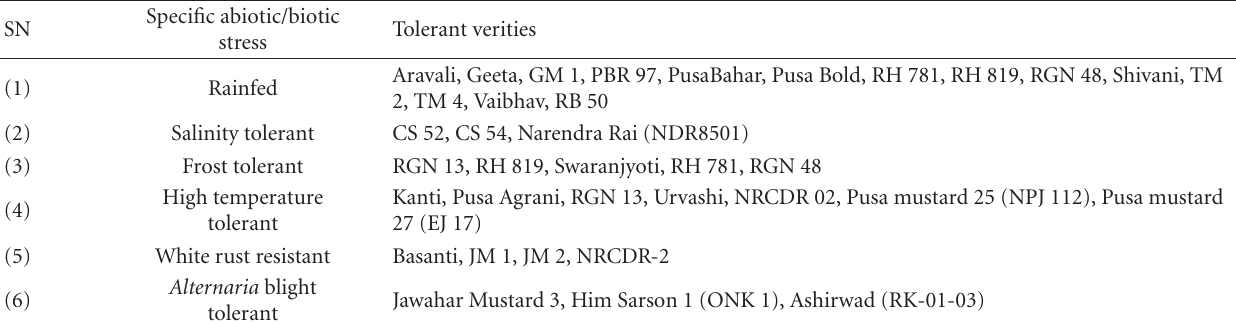
Table 3: Varieties tolerant to various abiotic and biotic stresses of mustard ( Brassica juncea ). Specific SN